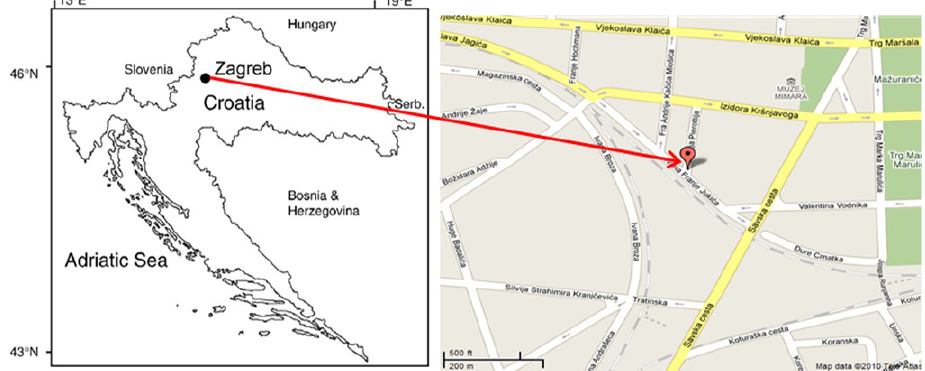
Figure 1. Position of the sampling site (adapted from Google Maps).